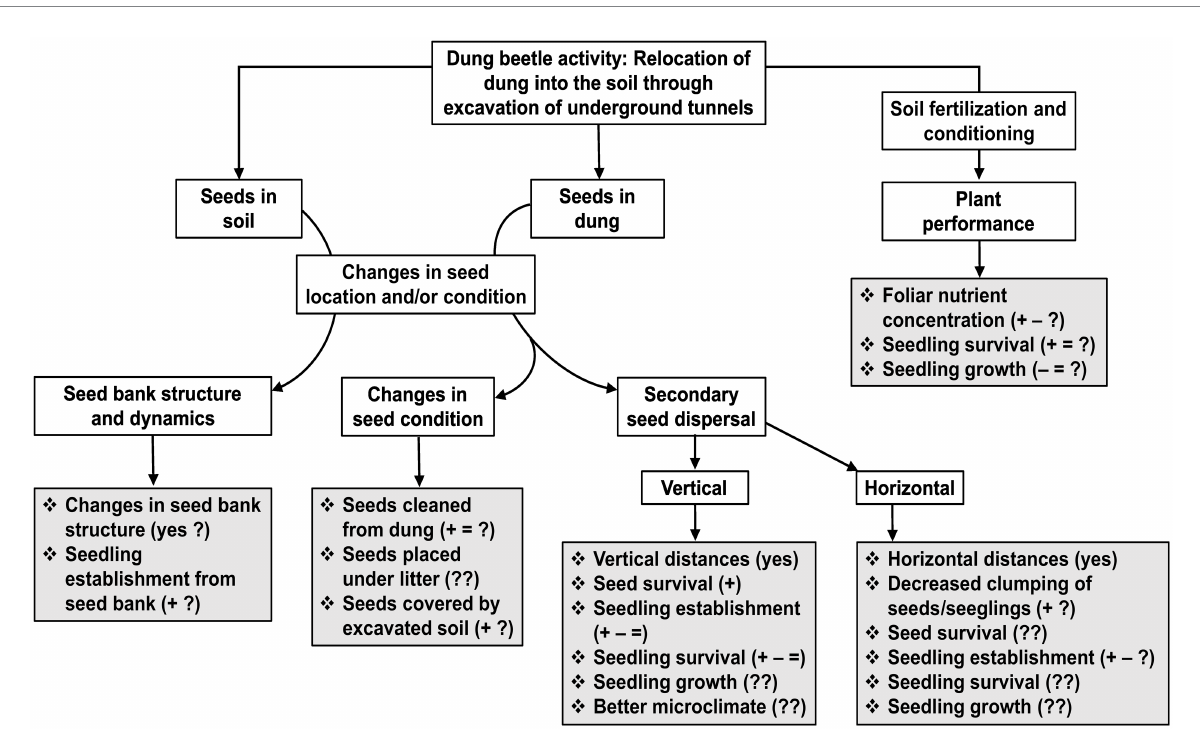
FIGURE 1 Flowchart showing the consequences that dung beetle activity can have on plants that are reviewed in this article (Secondary seed dispersal; Seed banks; and Plant performance). The activity of dung beetles that we focus on, is the relocation of animal feces (mostly mammal dung) from the soil surface into deeper soil layers, which in turn occurs through the excavation of soil to build underground tunnels and chambers for feeding and nesting. The consequences for plants result from a direct interaction between dung beetles and seeds (seeds in dung and seeds in soil), and from an indirect interaction between beetles and plants, which is mediated through soil fertilization and conditioning. Grey boxes show specific responses that have been measured (those followed by “yes”, “+”, “–“, and/or “=”), or have been suggested to occur. Signs indicate positive (+), negative ( − ), and no effect (=) of dung beetles reported for each of the responses; question marks indicate that a response has been little studied (?), or not at all (??). Studies that have assessed one or more of these responses are shown in Table 1. For secondary seed dispersal, information for specific plant species can be found in Supplementary Table